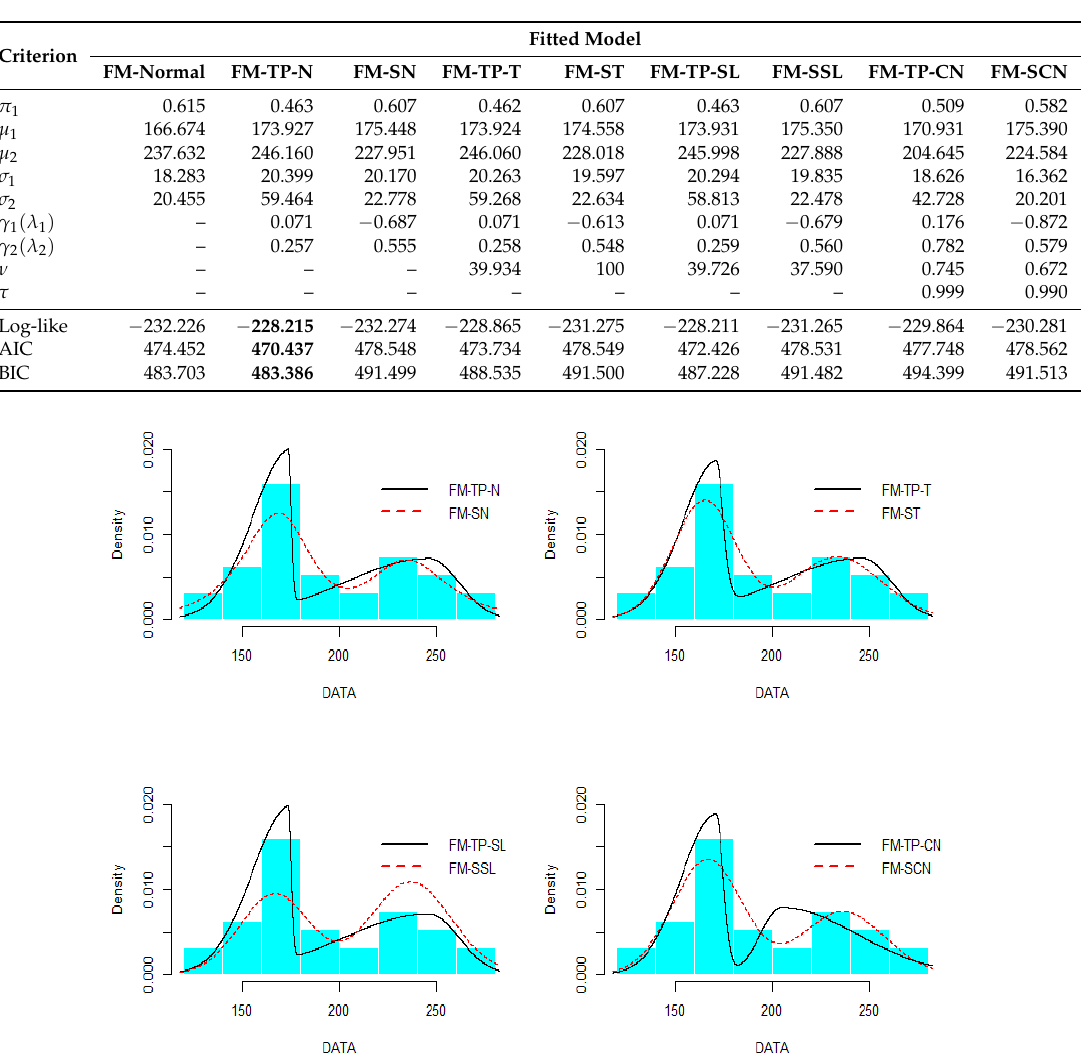
Table 8. ML estimation results and model selection criteria for fitting FM-TP-SMN models to the UScrime data. The best values are marked in bold.